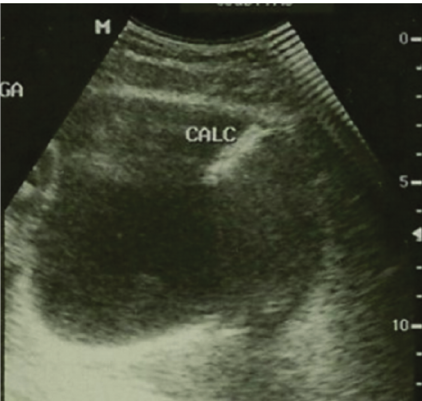
Figure 1: Transabdominal ultrasonography showing a 20 mm calculus located in the bladder dome.